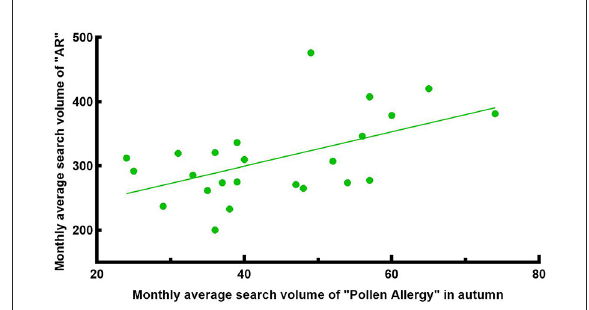
FIGURE9 Correlation between the search volume of “AR” and “Pollen Allergy” in autumn from 2014 to 2021.